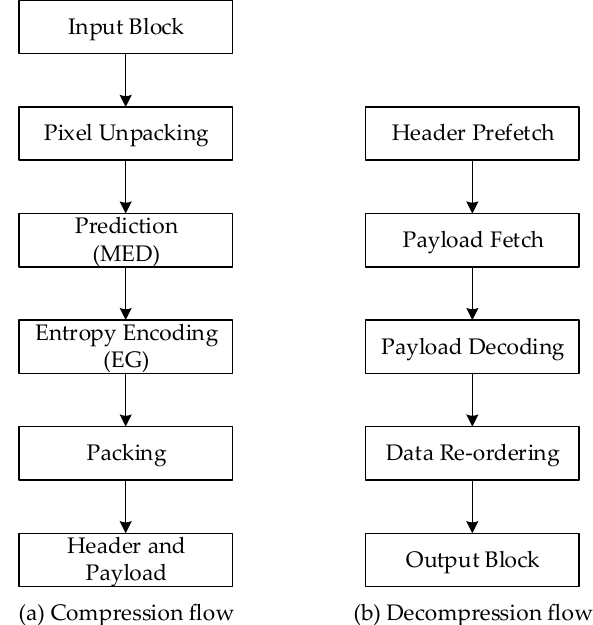
Figure 2. ( a ) Compression and ( b ) decompression flow in proposed LEC. Abbreviations: MED, median edge detection; EG, exponential Golomb.